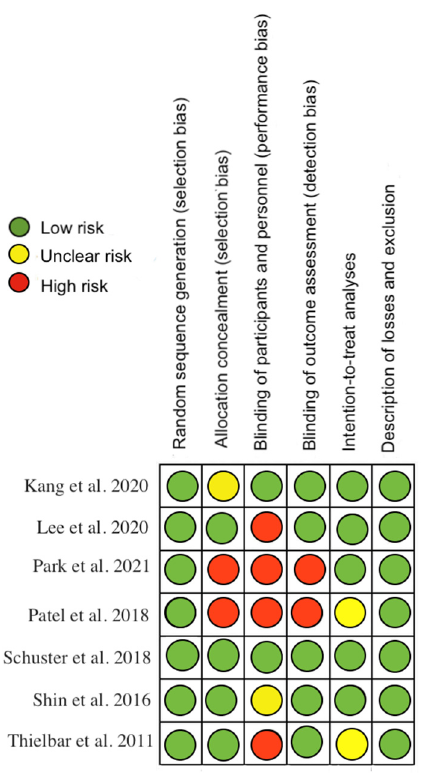
Figure 2. Risk of bias for each included study [18–24].